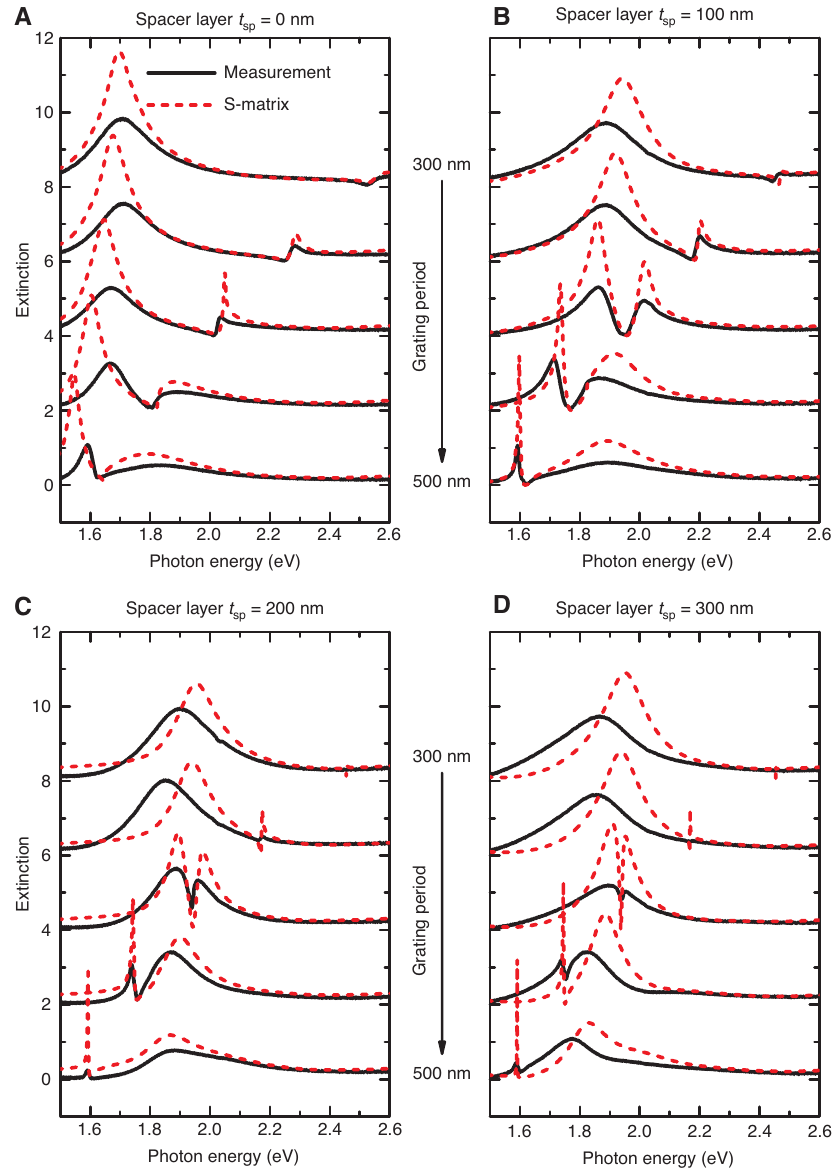
Figure 2: Coupling strength behavior for different spacer layer thicknesses. Measured (black solid) and simulated (red dashed) extinction spectra for spacer layer thicknesses t and (D) 300 nm. The grating period is varied between 300 nm (top) and 500 nm (bottom) in steps of 50 nm for each panel. The spectra are shifted upward for clarity in each